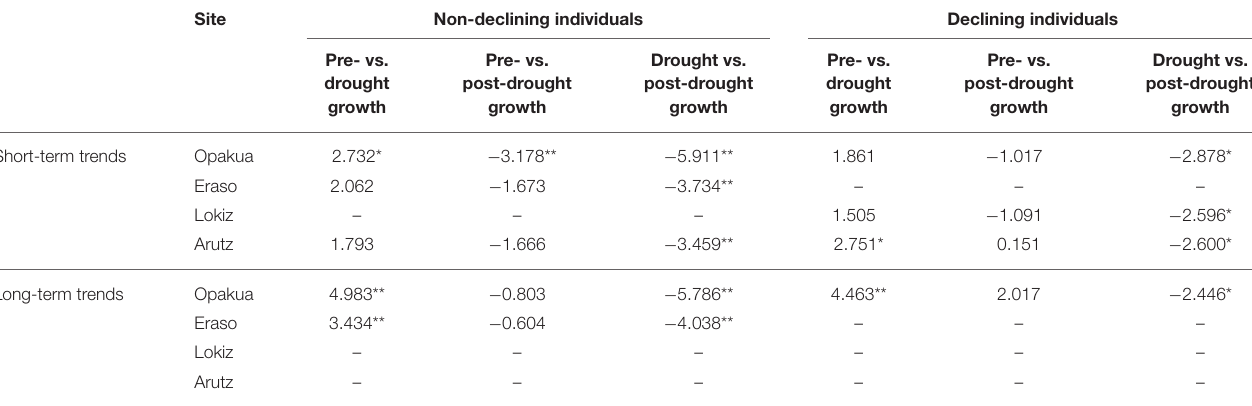
TABLE 3 | Differences between pre- and post-drought growth (basal area increment) observed for declining and non-declining beech individuals in the four study sites in response to the 2003–2005